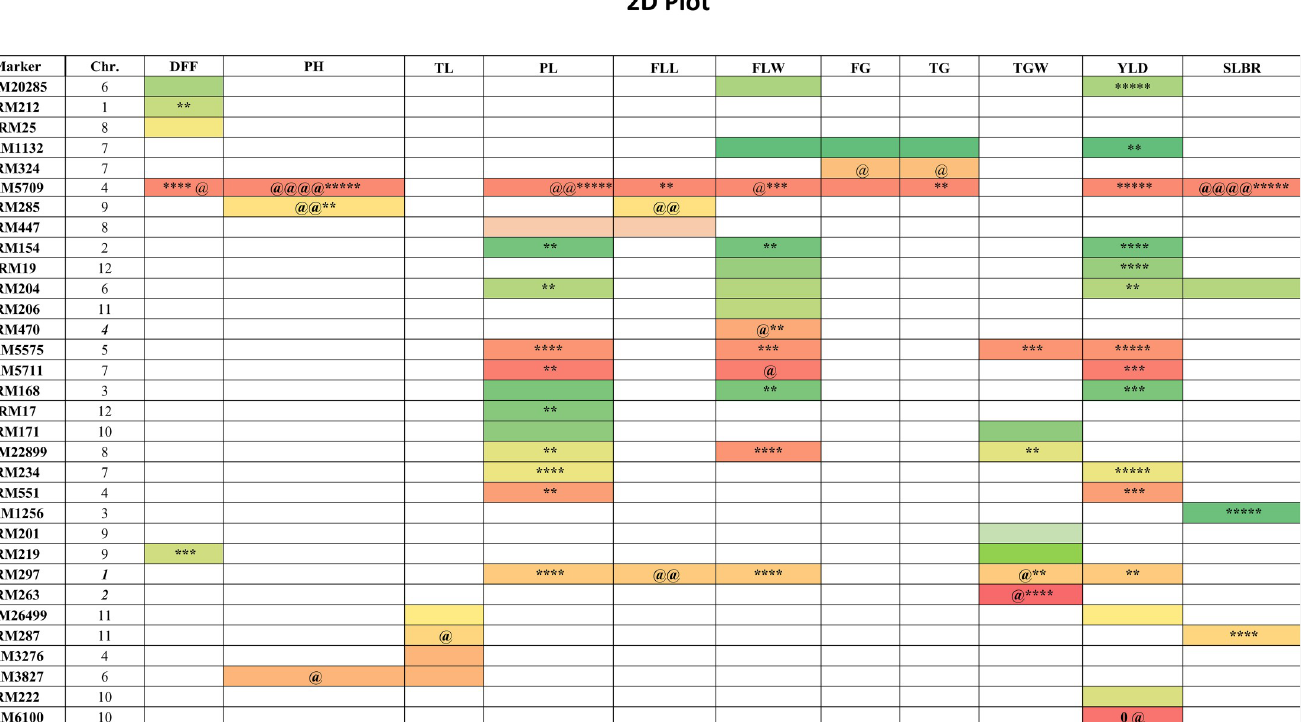
PLOS ONE | https://doi.org/10.1371/journal.pone.0227785 July 16,